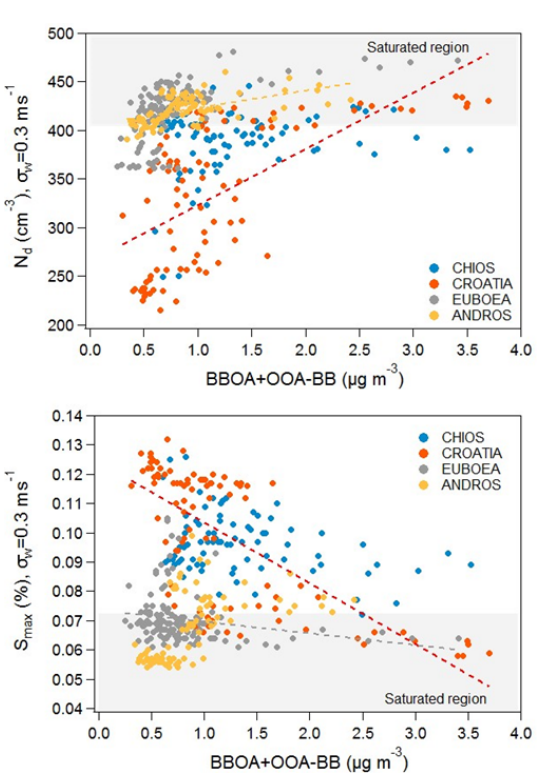
Figure 10. Droplet number concentration (top panel) and cloud maximum supersaturation (bottom panel) for each fire event as a function of BB influence, expressed by the sum of BBOA and OOA- BB ACSM